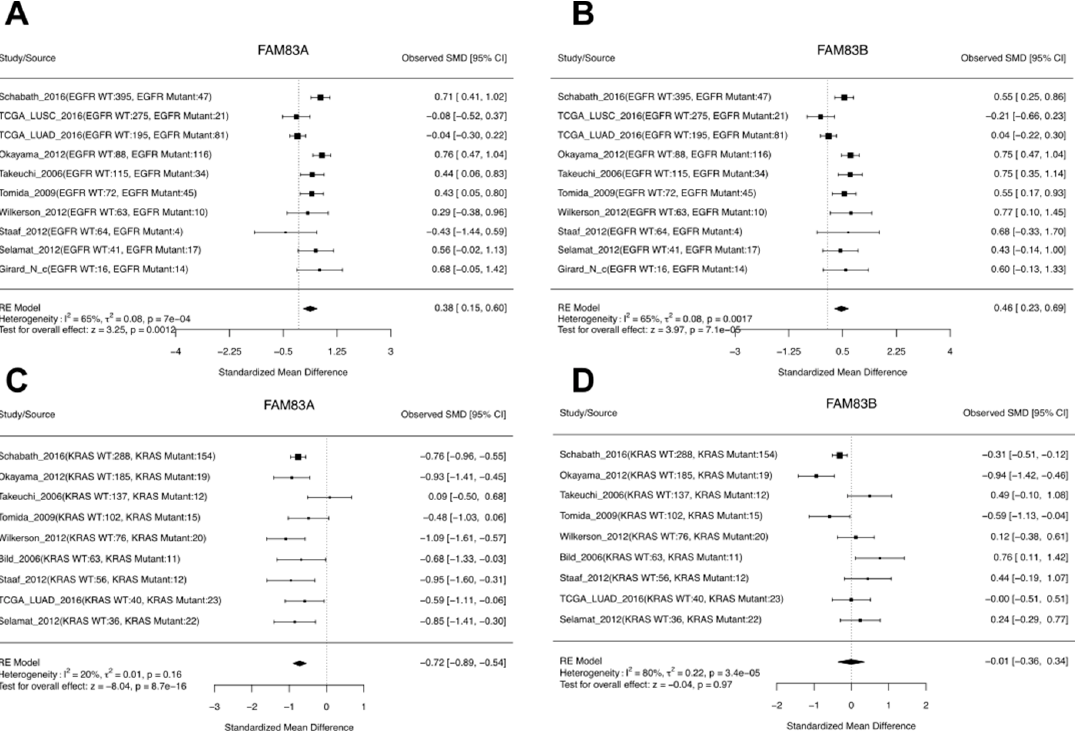
Figure 6. Expression difference between tumors bearing mutations in EGFR or KRAS compared to WT for FAM83A and FAM83B. ( A , B ) Forest plots showing the FAM83A ( A ) and FAM83B ( B ) expression difference between tumors with or without EGFR mutations. ( C , D ) Forest plots showing the FAM83A ( C ) and FAM83B ( D ) expression difference between tumors with or without KRAS mutations.